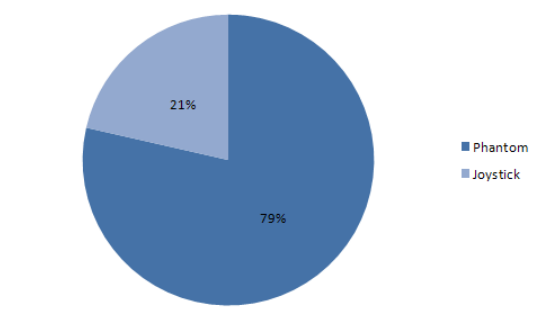
Fig. 25. Preference of volunteers with regard to the input device